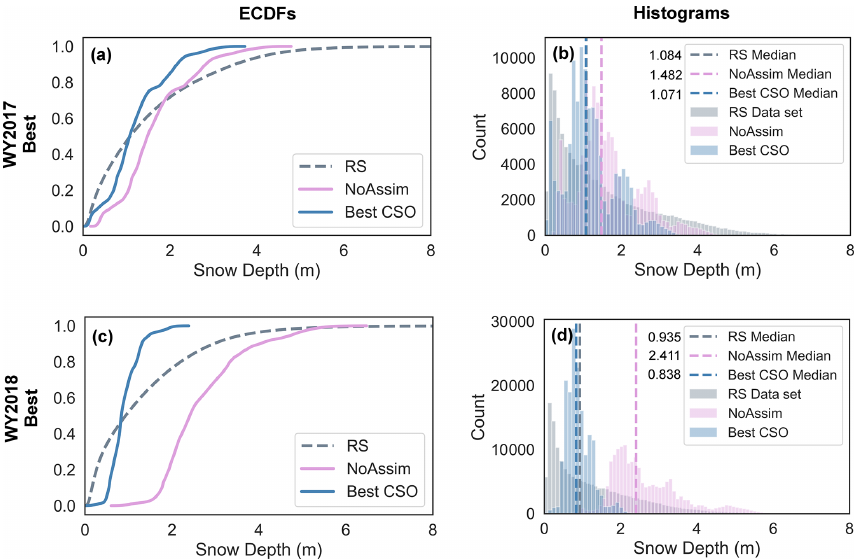
Figure 8. Histogram and distribution plots. The empirical cumulative distribution functions (ECDFs) and histograms from the best CSO simulation, the no assimilation case, and the remote sensing (RS) data sets during WY2017 (a, b) and WY2018 (c, d) .